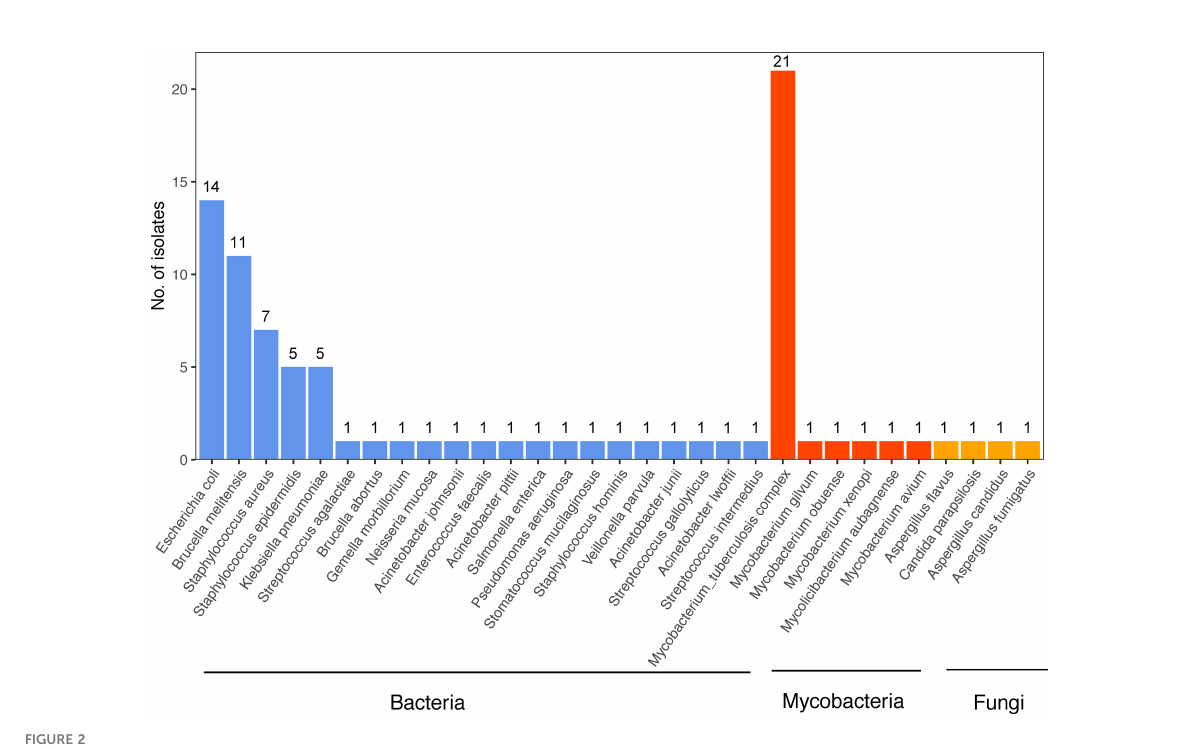
FIGURE 2 Isolates of pathogens detected by the clinical golden